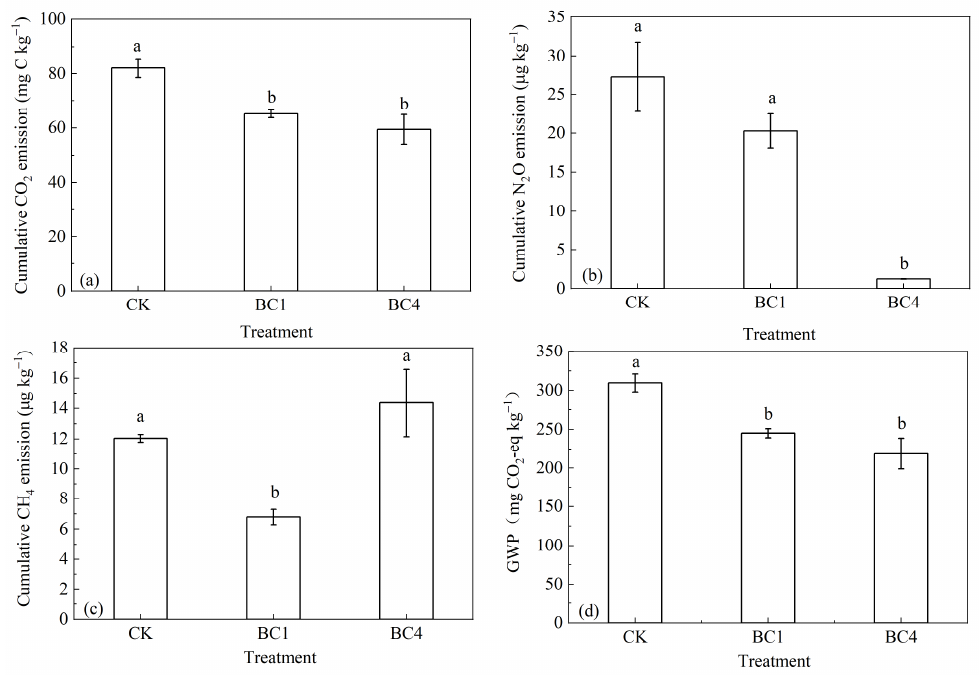
Figure 3. The effects of biochar addition on soil cumulative ( a ) CO 2 , ( b ) N 2 O and ( c ) CH 4 emissions and ( d ) GWP during the 30-day incubation. Different letters indicate significant variations among treatments at the same incubation time at p < 0.05. Vertical bars indicate the standard error of the mean (n =